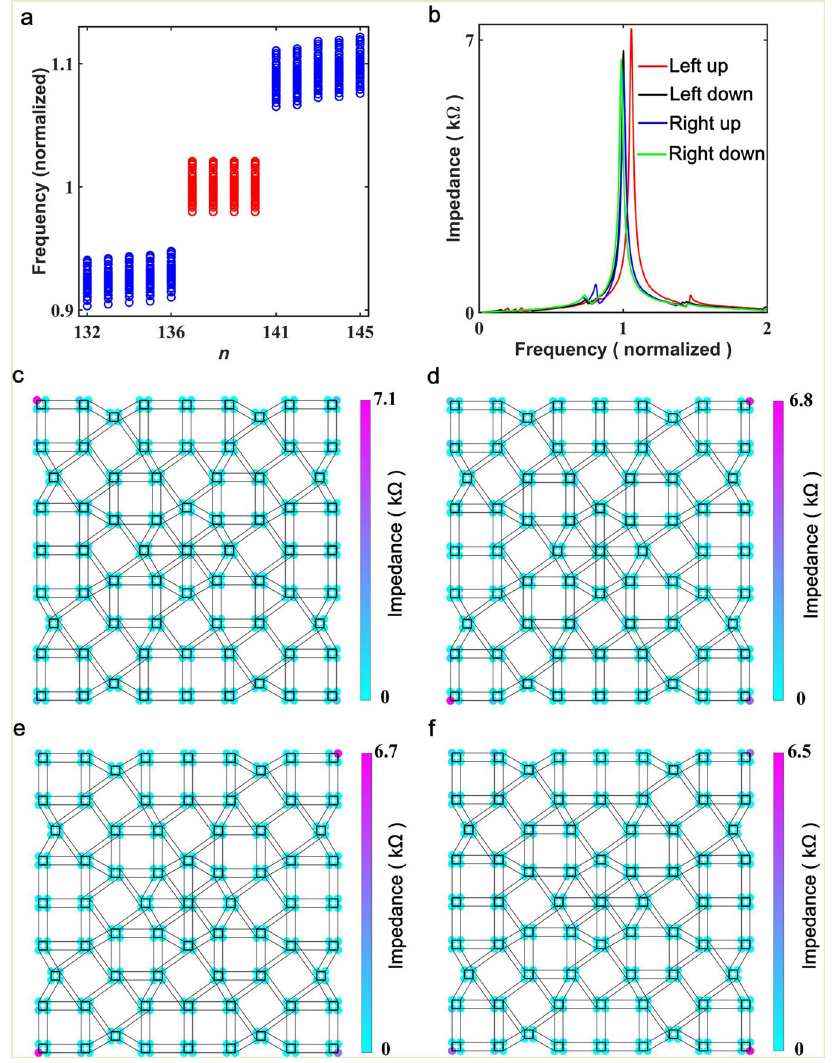
Fig. 3 Robustness of corner states on the circuit. a The normalized eigenfrequencies ω / ω 0 of the circuit Laplacian J ( ω ) with element errors ±5% and the number of the samples is 300. The eigenfrequencies of the corner and bulk states are indicated by the red and blue circles. b The experimental two-point impedances measured between the left-up/left-down/right-up/right-down corner site and another bulk site. c – f The experimental impedance distributions at the frequencies of the left-up/left-down/right-up/right-down corner